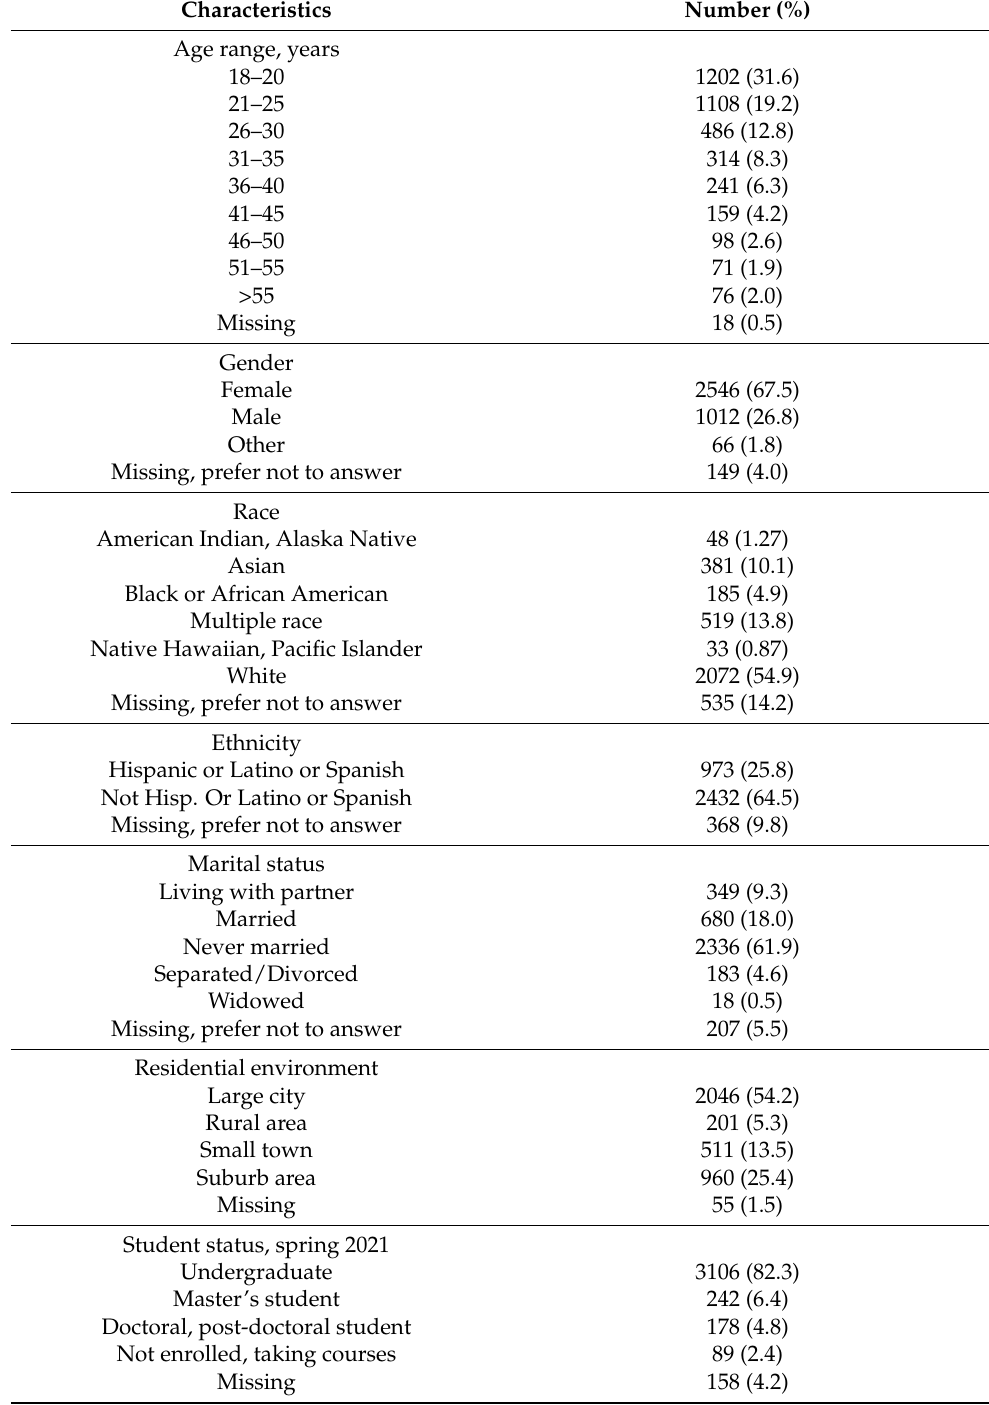
Table 1. Characteristics of respondents in the NSHE student survey, February–March,